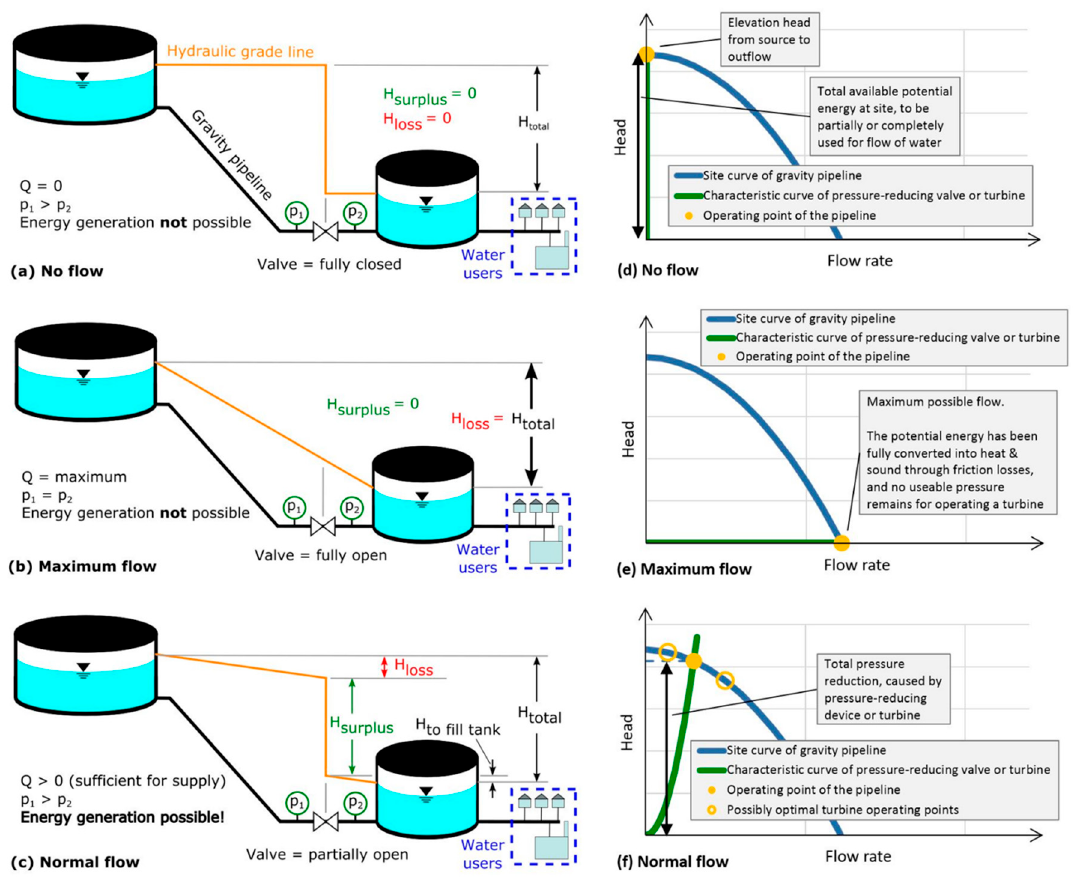
Figure A1. The basic hydraulics of a drinking water hydropower system prior to the installation of a turbine, illustrated under three conditions (no flow, maximum flow, normal flow) using the hydraulic grade line and process diagram ( a – c ) as well as a diagram of head vs. flow rate ( d – f ).